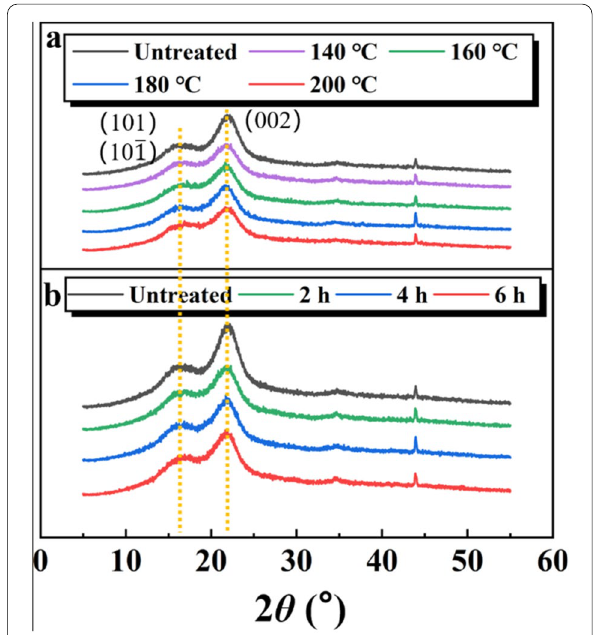
Fig. 3 XRD spectra of untreated sample and the treated samples treated a at varied temperature (140, 160, 180 and 200 °C) for 6 h and b at 200 °C for varied time (2, 4 and 6 h), respectively